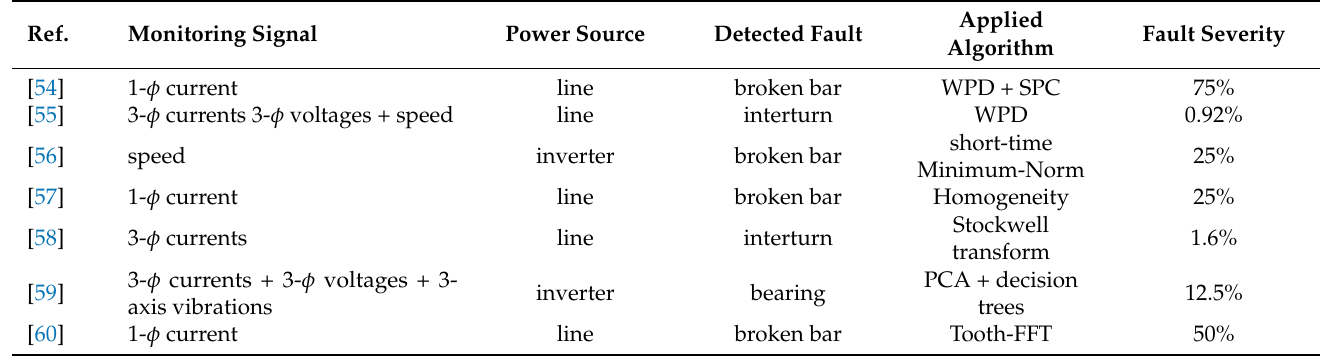
Table 3. Comparison of early fault detection methodologies applied on IM under transient